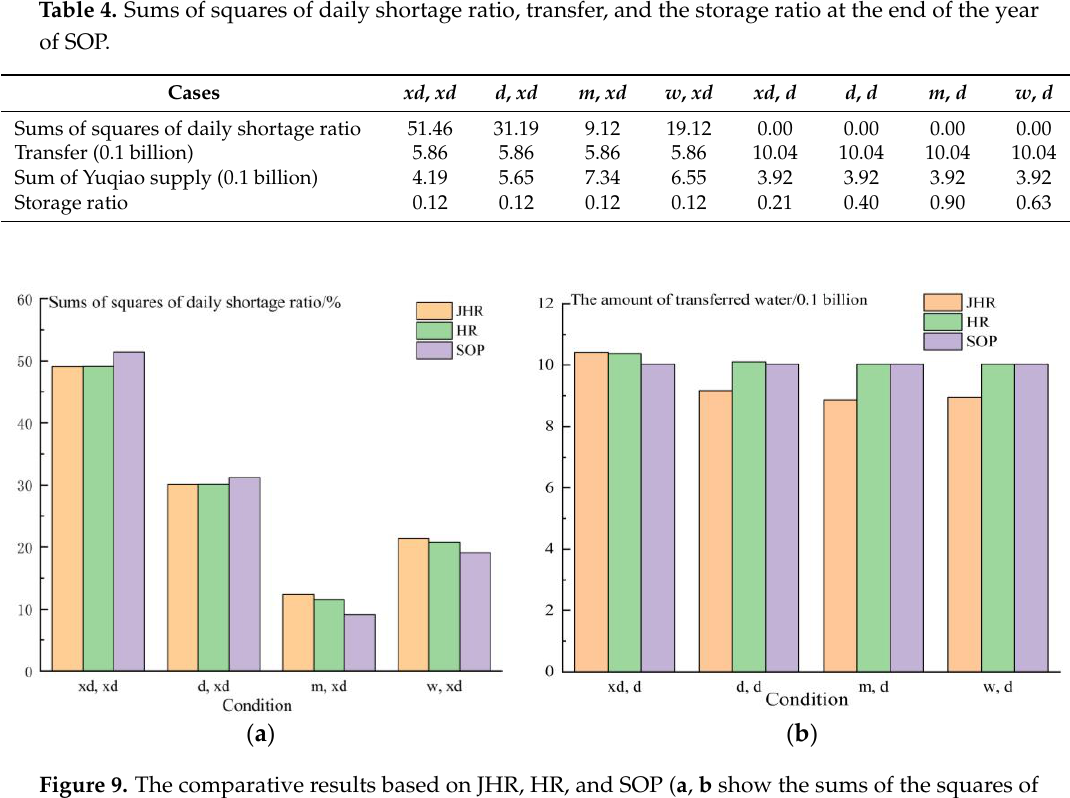
daily shortage ratio and the amount of transferred water,